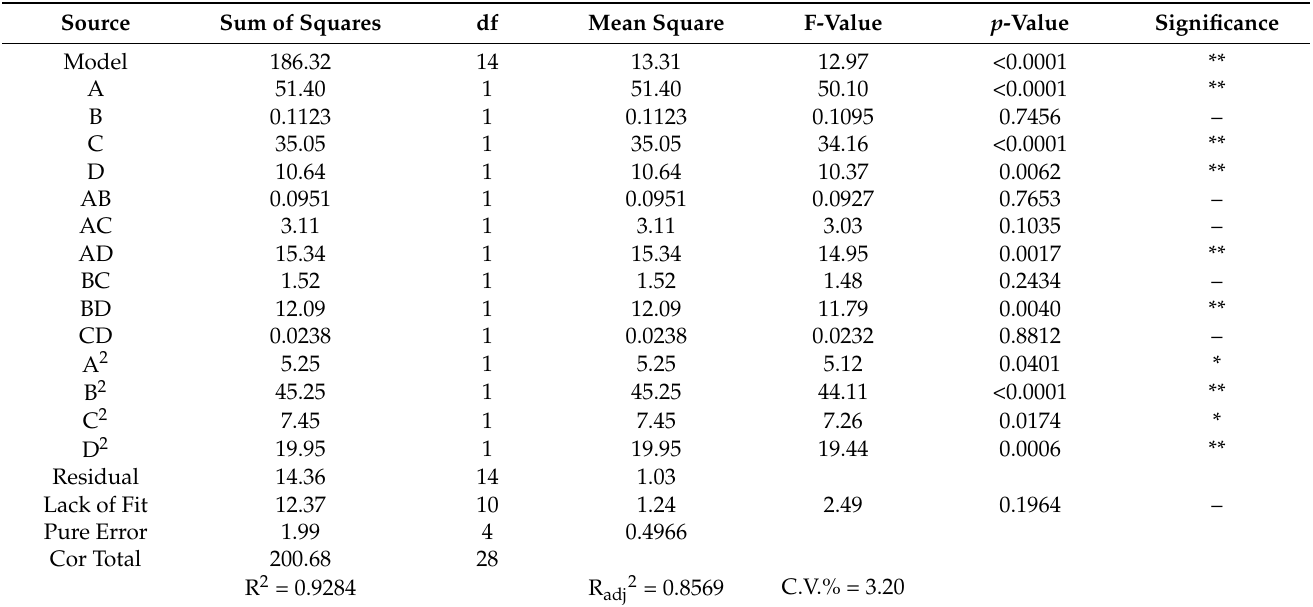
Table 3. The results of the ANOVA for the regression equation fitted the response content.